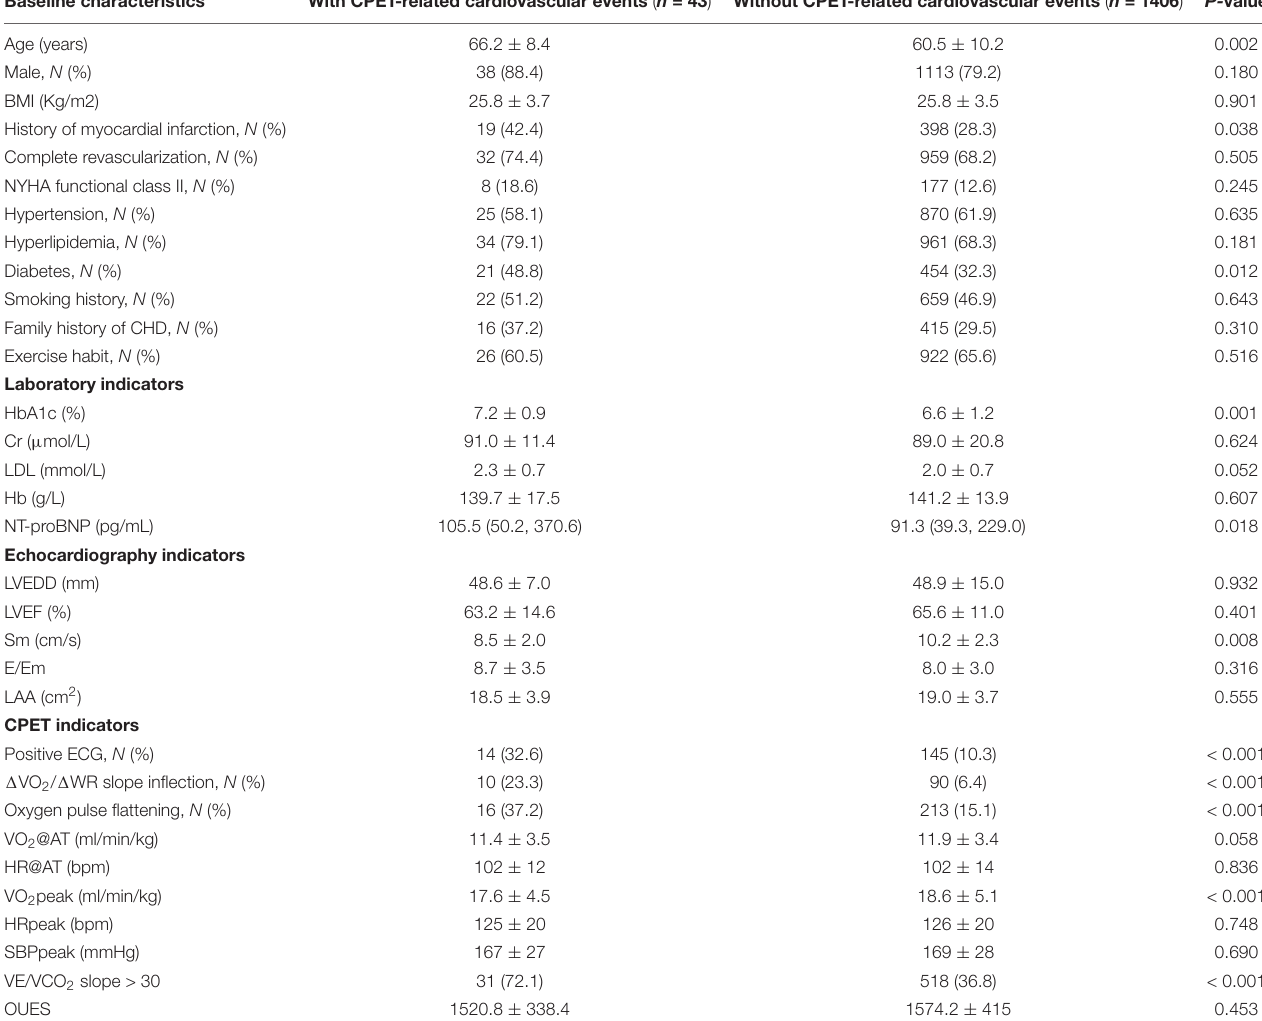
TABLE 2 | Baseline characteristics of patients with CHD after PCI grouped by CPET-related cardiovascular events. Baseline